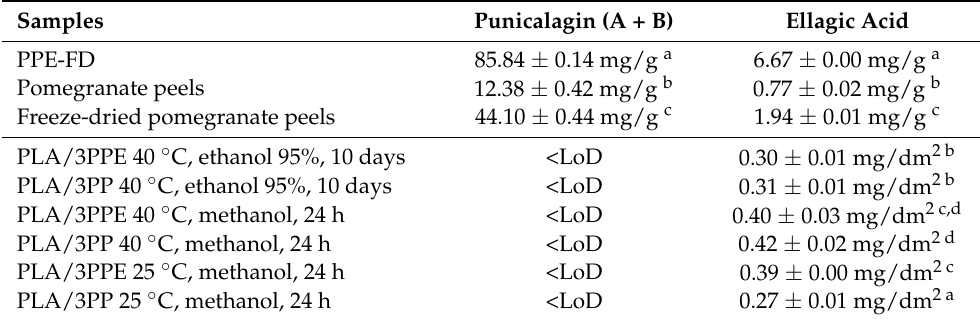
Table 5. Quantification of punicalagin (A + B) and ellagic acid in the pomegranate extract, pomegranate peels, and active